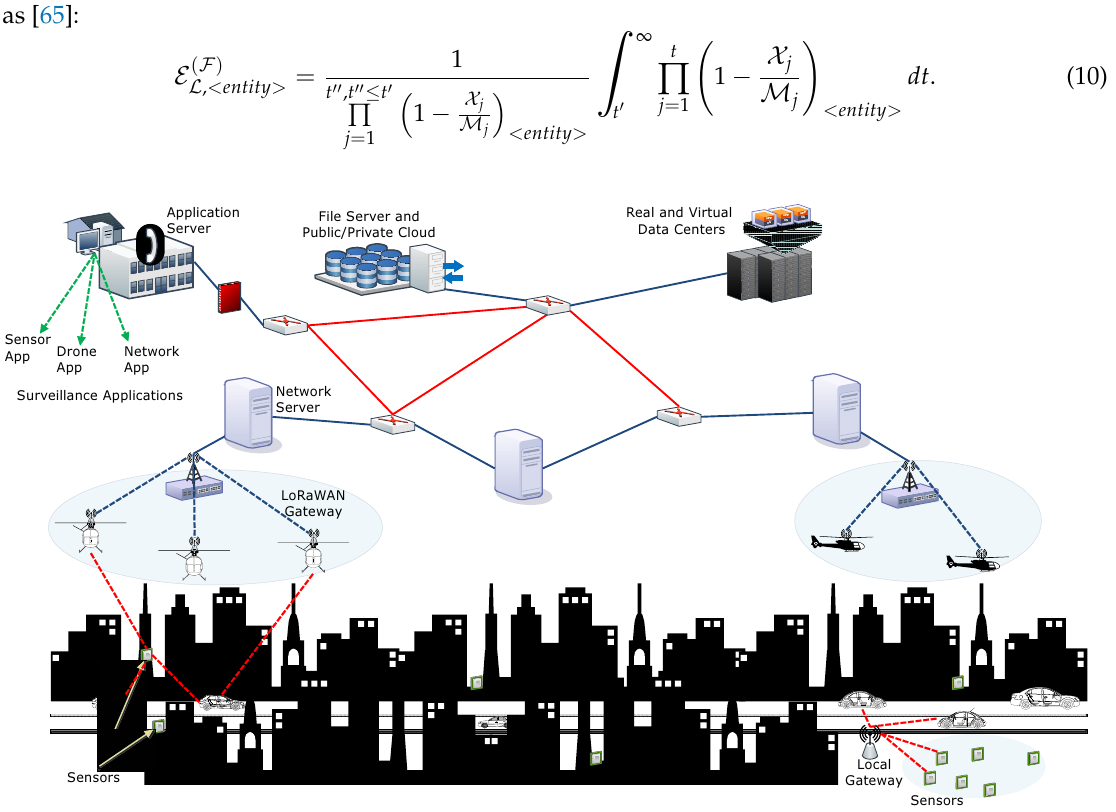
Figure 2. An exemplary illustration of drone-enabled LoRaWAN-based surveillance in